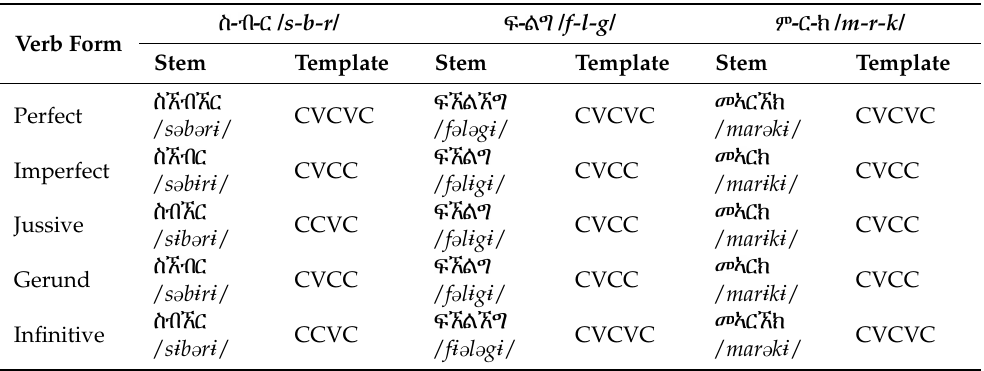
Table 2. Templates of tri-radical verbs types.